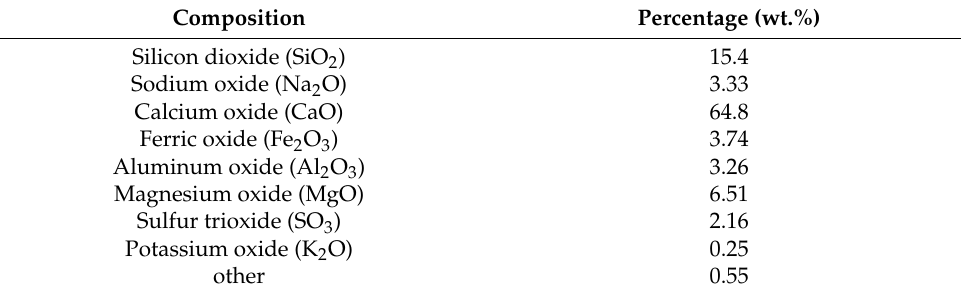
Table 2. Chemical constituents of ICM (Inorganic coating material).